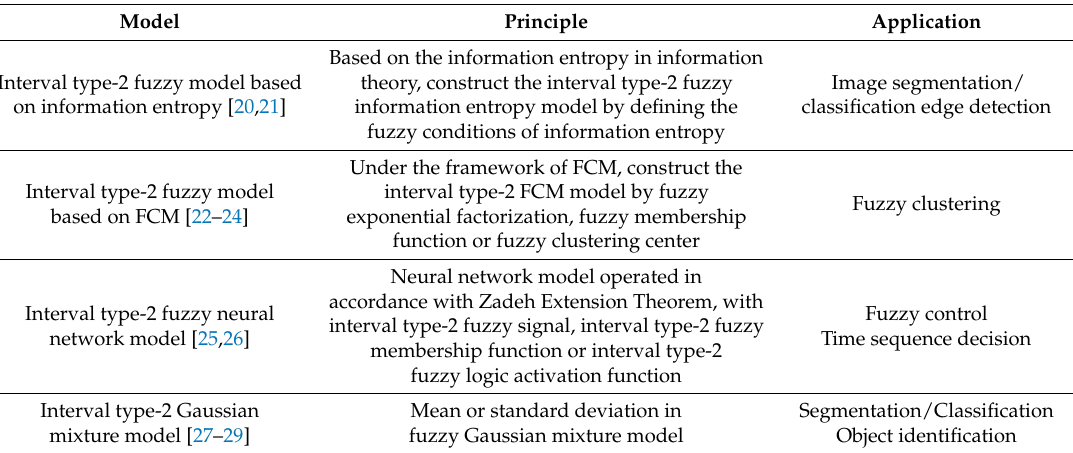
Table 1. Type, principle, and application of interval type-2 fuzzy